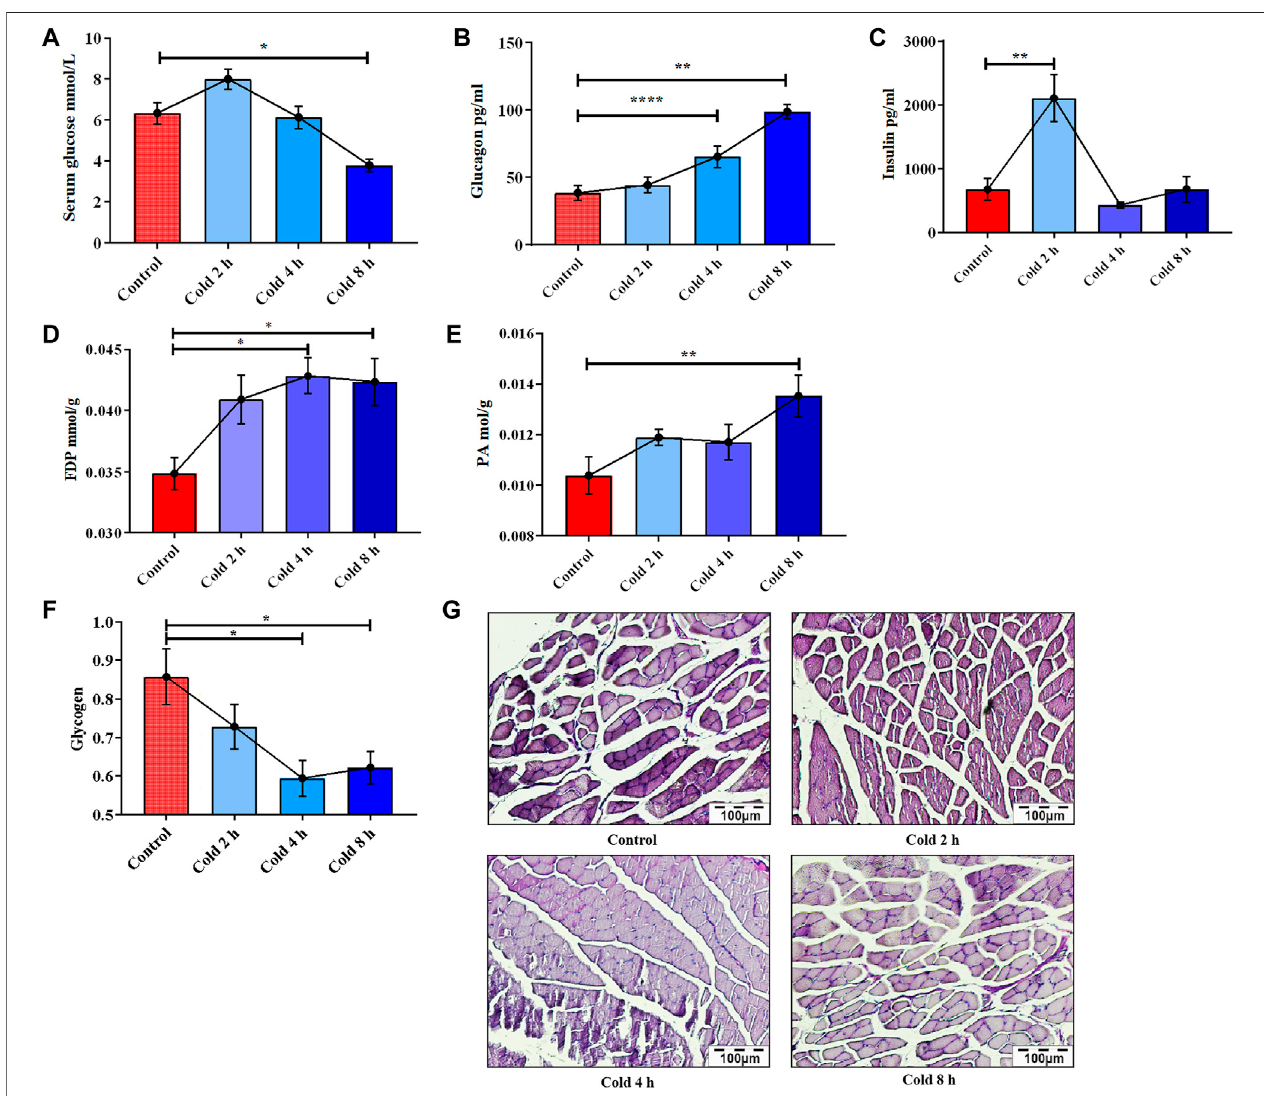
FIGURE1| Changesofglucose metabolism inducedbyacute coldexposureinmice.Effect ofacutecold exposure onserum glucoselevel (A) , glucagonlevel (B) , insulinlevel (C) inmice.EffectofacutecoldexposureonFDPlevel (D) andPAlevel (E) intheskeletalmusclesofmice.Effectsofacutecoldexposureonglycogenlevel (F, G) in skeletal muscle of mice. The data are presented as the mean ± SEM (n (cid:1) 8). Statistically signi fi cant differences are indicated; * p < 0.05, ** p < 0.01. FDP, fructose- 1,6-diphosphate; PA, pyruvic acid.